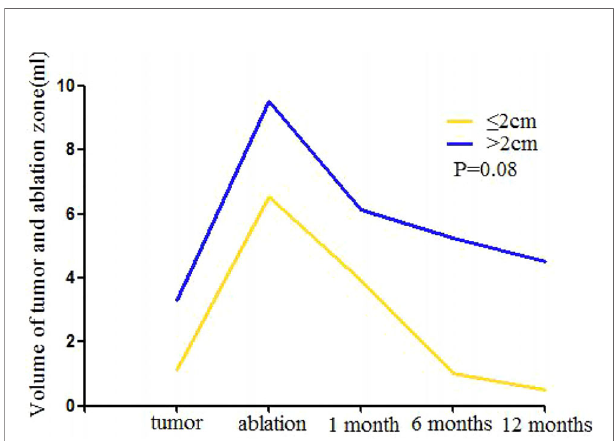
FIGURE 4 | Mean volume of mass ≤ 2.0cm and >2.0cm at baseline (time of MWA) and at follow-up after treatment. One month after MWA the increased volume shows the enlarged ablation zone compared with index mass. The ablation area will shrink signi fi cantly during the 6 months after MWA and then reach stability gradually for both groups. After 6 months, the volume of mass ≤ 2.0 cm reached the level of before MWA, the volume of mass >2.0 cm was larger than the index mass continuously. There is no signi fi cant difference between two groups in volume reduction after MWA (P =